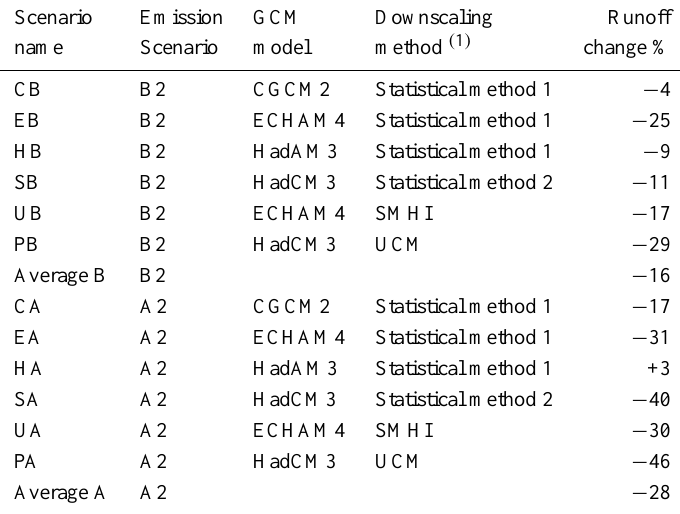
Table 2. Climate change runoff projections for the Ebro basin